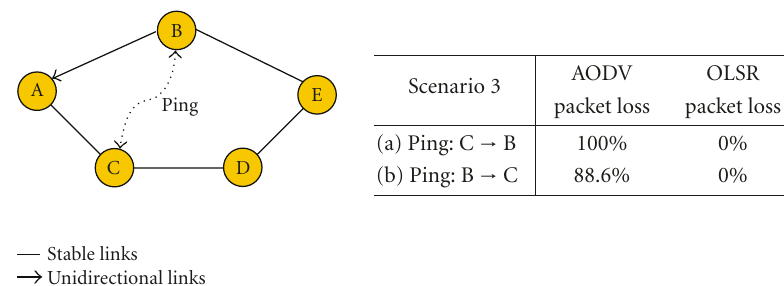
Figure 9: Unidirectional links: scenario 2 (network topology and experimental results).